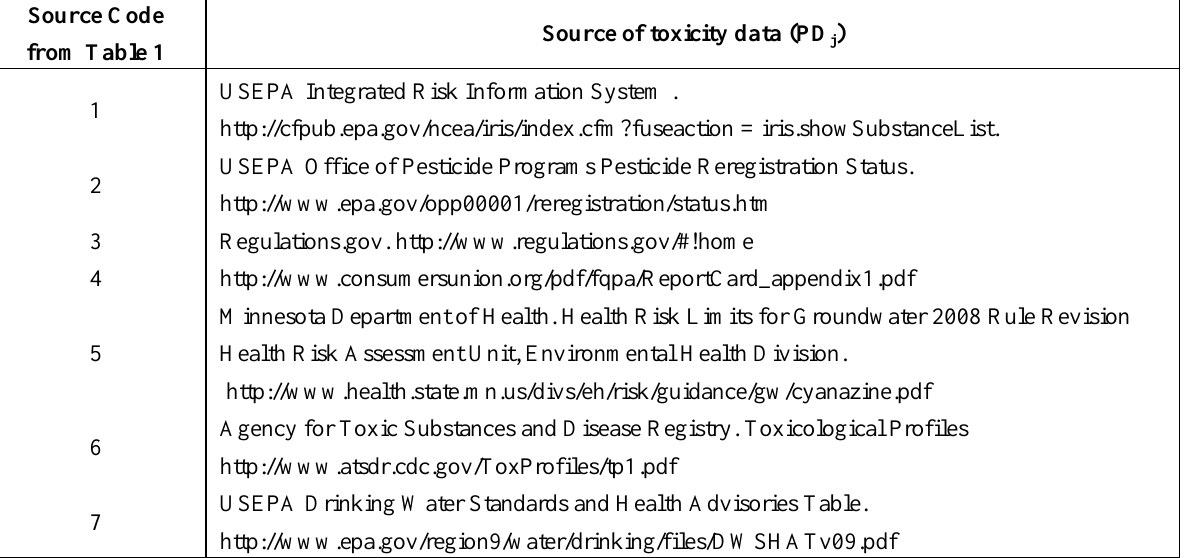
Table 2. Sources of Toxicity Data Cited in Table